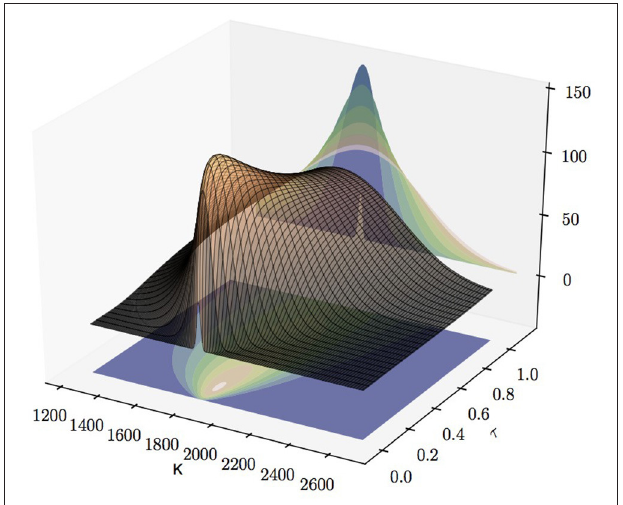
FIGURE 1 | The derivative of Heston’s call price w.r.t. the volatility σ 0 .